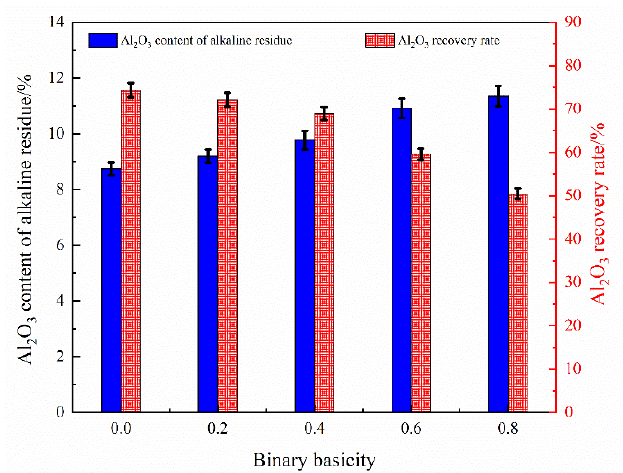
Figure 15. Effects of the slags obtained from smelting separation at different basicity levels on the recovery rates of Al 2 O 3. (The slag was subjected to firing at 900 °C for 120 min and leaching at 95 °C for 120 min, with a liquid-to-solid ratio of 10 mL/g at 300 rpm). (The Al 2 O 3 contents of modified slag obtained at different basicity levels were 17.11%, 17.88%, 18.51%, 19.27%, 19.72%, respectively. The yields of leaching residues obtained at different basicity levels were 50.16%, 54.16%, 58.86%, 71.32%, and 86.13%, respectively.).